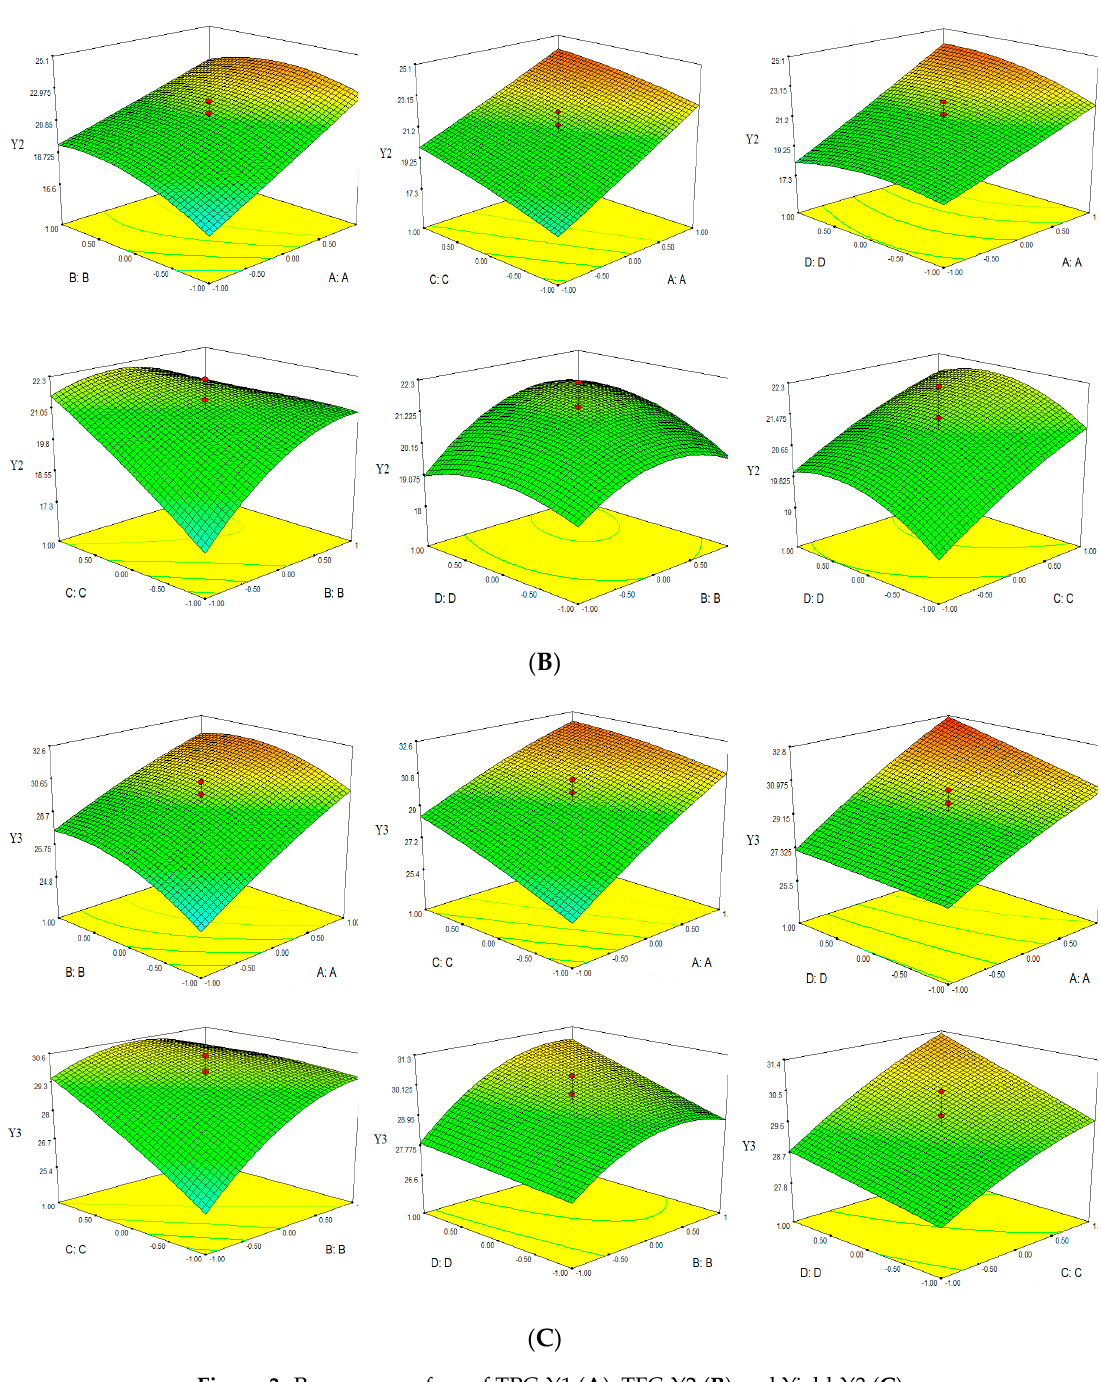
Figure 3. Response surface of TPC-Y1 ( A ), TFC-Y2 ( B ) and Yield-Y3 ( C ).